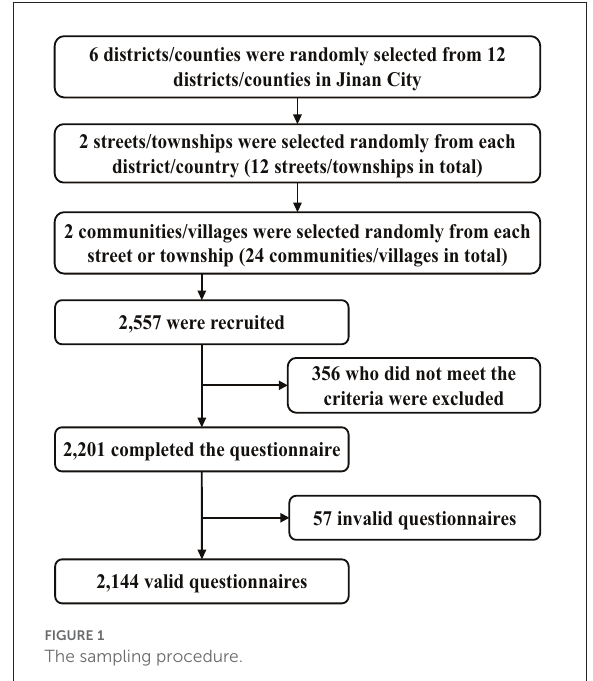
FIGURE1 The sampling